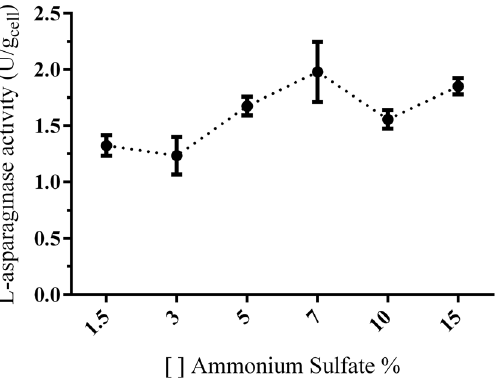
Figure 5. Effect of ammonium sulfate on L-asparaginase activity by Penicillium cerradense cultivated for 4 days at 30 °C. The results are presented as mean of enzyme activities with standard deviation for each run (n =